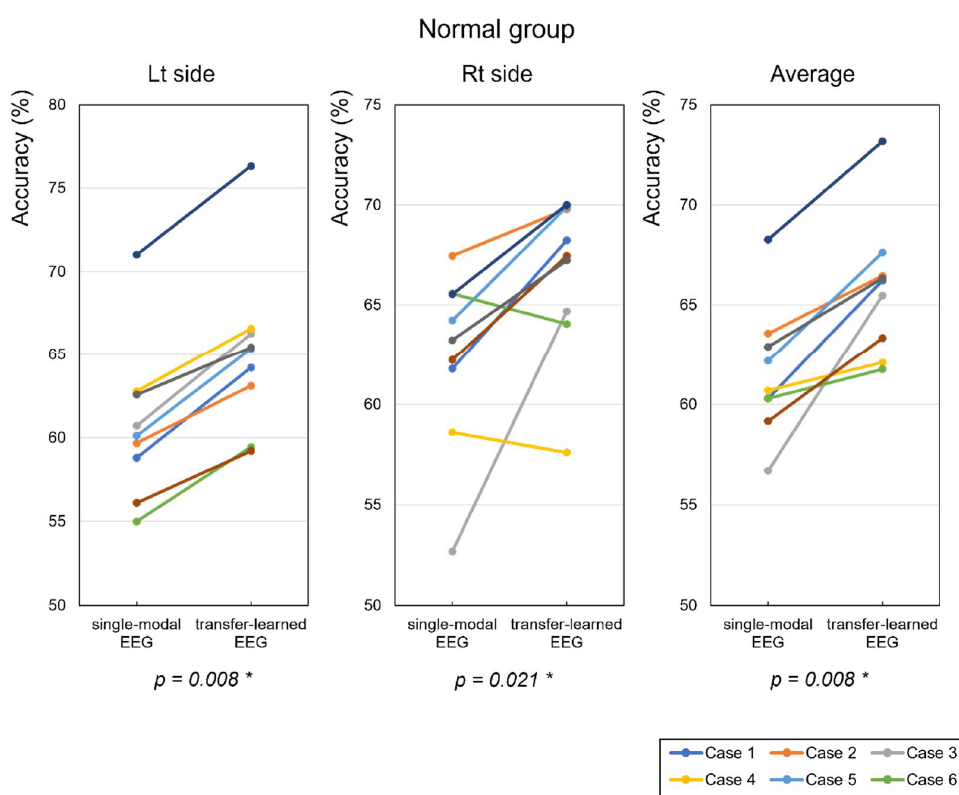
Figure 9. Classification accuracy for wrist dorsiflexion and volar flexion, wrist radial deviation and ulnar deviation, and hand grasping and opening, as performed by each control subject (%). “Lt side” refers to the accuracy result for the left arm, and “Rt side” to that for the right arm. * p -value between single-modal EEG and transfer-learned EEG by Wilcoxon signed-rank